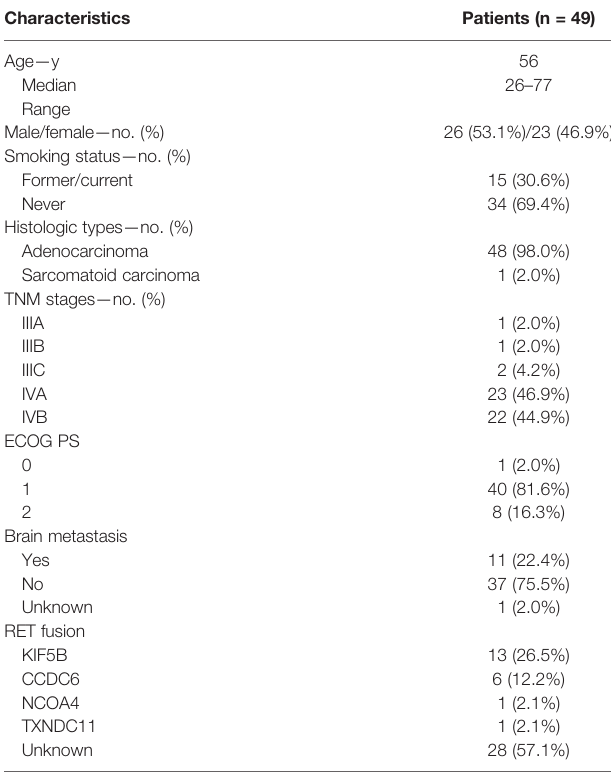
TABLE 1 | The baseline information of patients at the time of